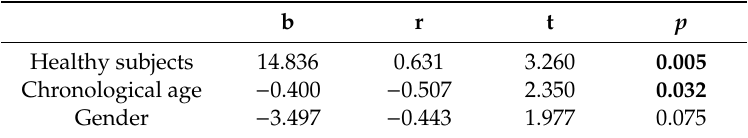
Table 2. Multiple linear regression of the influence of being healthy subject, age and gender on ∆ T1 − T0 DNAmAge for all subjects (n =